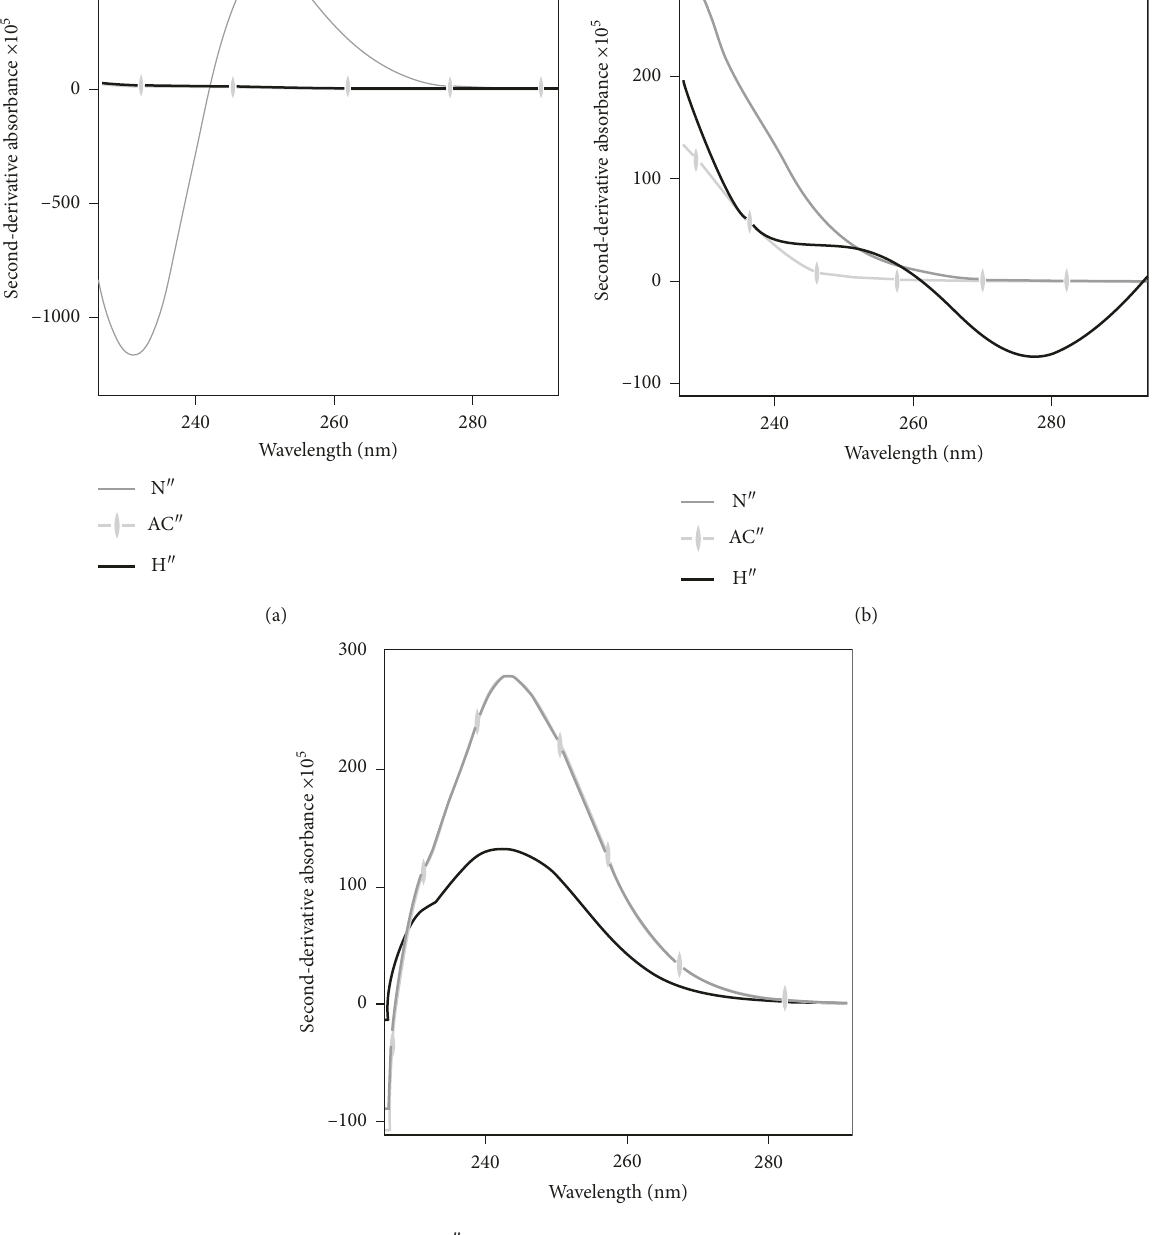
2 S solution at 235 µ mol/L), (b) sulfites (Na 2 SO 3 λ were of 10mm and 8nm, Δ